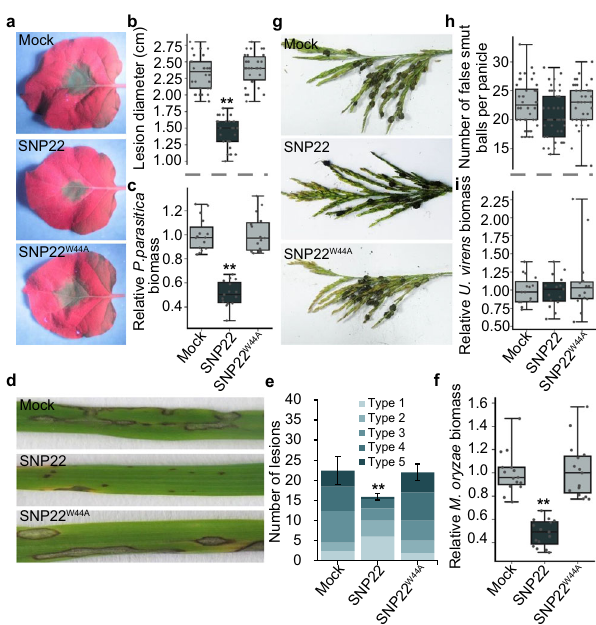
Fig. 6 SNP22 triggers induction of disease resistance in N. benthamiana and rice. N. benthamiana leaves, rice panicles, and rice leaves were pretreated with 1 μ M of the indicated peptide for 24 h before pathogen inoculation. Buffer served as a mock treatment. In box plots, whiskers indicate the minimum and maximum values, line indicates the median, the box boundaries indicate the upper (25th percentile) and lower (75th percentile) quartiles. (** P < 0.01 compared with Mock, two-sided Dunnett ’ s test). a – c Induction of disease resistance to P. parasitica var nicotianae in N. benthamiana . a Lesions were assessed under UV light and representative photographs were taken at 48 h post inoculation (hpi). b Statistical analysis of lesion diameters. Data was obtained from six independent experiments, each of which tested fi ve leaves for each treatment. c Relative biomass of P. parasitica in N. benthamiana leaves quanti fi ed by qPCR analysis of genomic DNA and normalized to mock treatment. Values from fi ve biological replicates were shown, which include three technical replicates for each biological replicate. d – f Induction of disease resistance to M. oryzae in rice leaves. d Representative photographs were taken at 7 dpi. e Quanti fi cation of lesion types per 5 cm leaf strip. See Methods for description of lesion types. Values represent the means ± SD of fi ve independent experiments, each of which used 10 leaves for each treatment. f Relative biomass of M. oryzae in rice leaves, quanti fi ed by qPCR analysis of genomic DNA and normalized to mock treatment. Values from fi ve biological replicates were shown, which include three technical replicates for each biological replicate. photographs were taken at 30 dpi. h Quanti fi cation of false smut balls per panicle. The data were collected from fi ve independent experiments, with a total of at least 44 panicles per line. i Relative biomass of U. virens in rice spikelets, measured by qPCR analysis of genomic DNA and normalized to mock treatment. Values from fi ve biological replicates were shown, which include three technical replicates for each biological